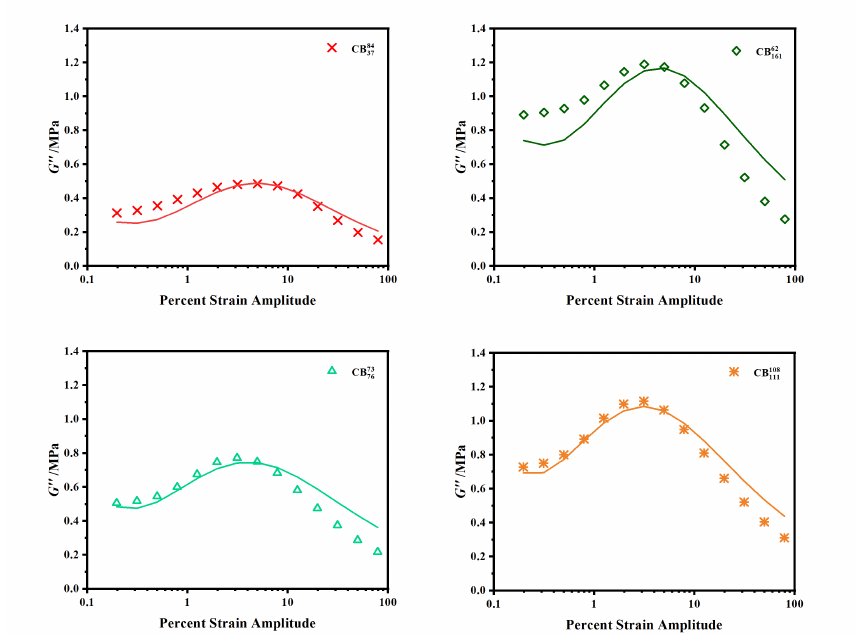
Figure 4. Curve optimizations of G (cid:48)(cid:48) where m and γ c are constrained as common fitting parameters. Symbols represent experimental data points; lines represent optimized curve